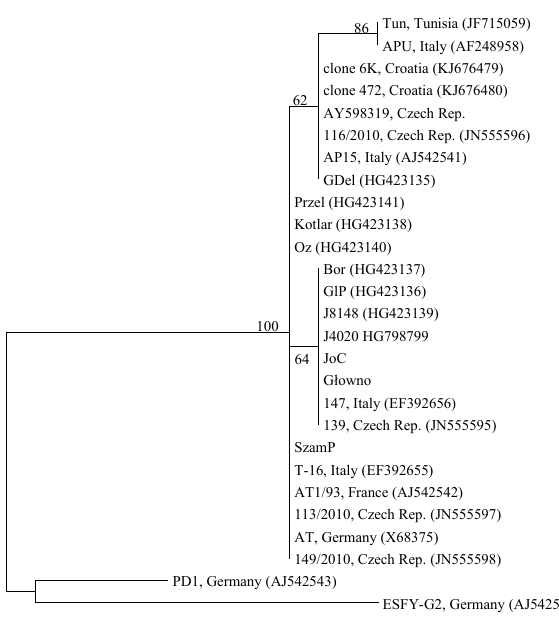
Figure 4. Phylogenic analysis of the 16S rDNA and 16S-23S spacer region sequences of 11 ‘ Ca. P. mali’ strains detect- ed from a survey of apple trees in Central and Southern Poland during 2010-2013 and apple proliferation strains available in GenBank. PD1 strain of ‘ Ca . P. pyri’ (AJ542543) and ESFY-G2 strain of ‘ Ca . P. prunorum’ (AJ542545) were included as outgroups. Phylogenetic trees were construct- ed by the neighbor-joining algorithm (MEGA 4.0) and the Kimura 3-parameter nucleotide substitution model in using 1,000 bootstrap replicates. Only bootstrap values higher than 60 are shown. The bar indicates the genetic distance as Kimura units.